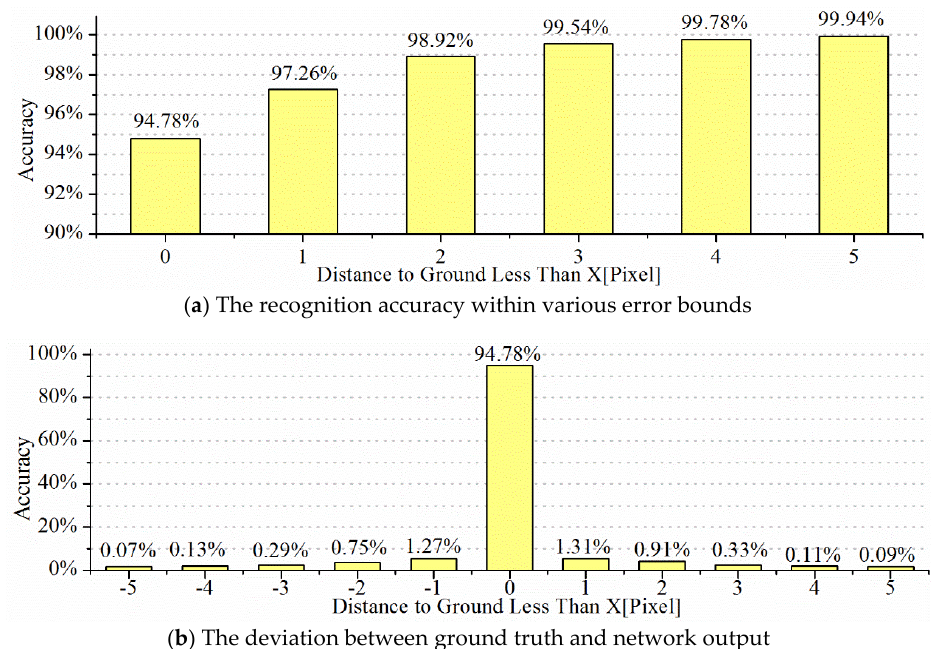
Figure 11. The data set classified within certain error bounds |e i − t i | < k with k ∈ {0, . . . , 5}. The image row containing the lane marking can be predicted in 97.26% within a precision of 1 pixel, and in 99.94% of the cases with 5-pixel precision in ( a ). ( b ) shows the evaluation result of e i − t i in test images .